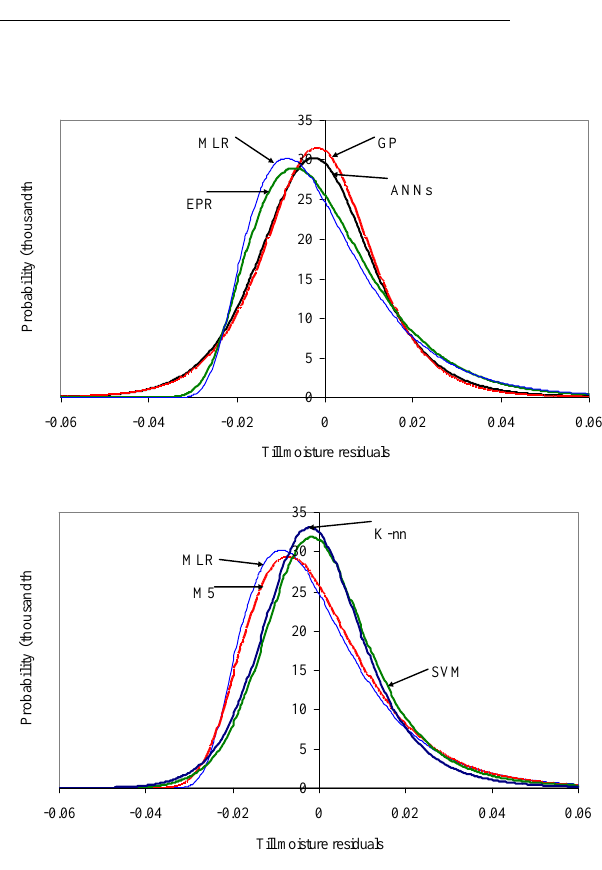
Fig. 9. Probability distribution of the 12 model residuals of all tech- niques (till moisture case